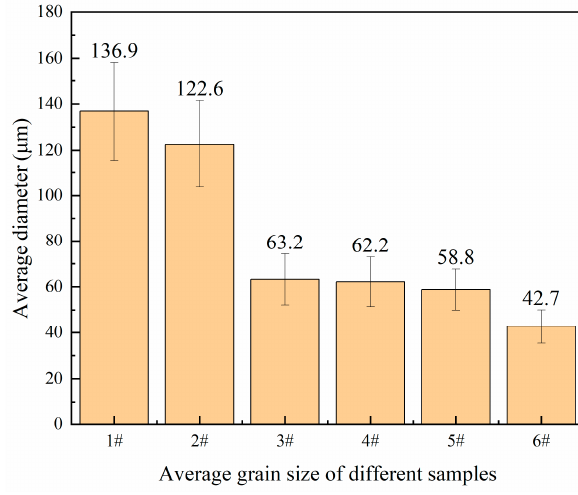
Figure 9. Average grain size of each sample.